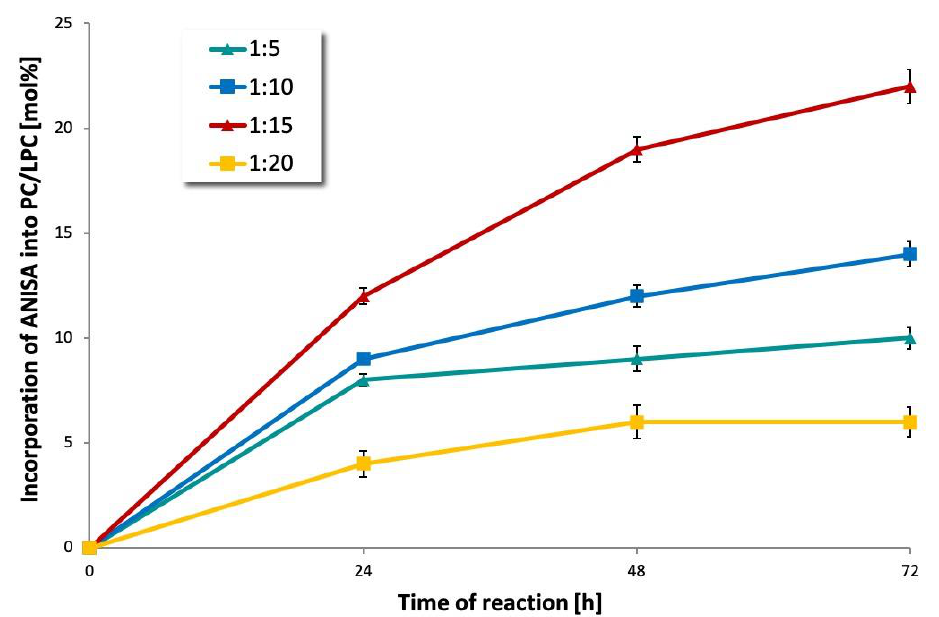
Figure 3. Effect of different substrate molar ratio on the incorporation of ANISA into egg-yolk PC in the acidolysis reaction (reaction conditions: solvent: toluene:chloroform (9:1 v/v) 2mL, enzyme load 30% (w/w) Novozyme 435, temperature 50 °C). Vertical bars represent SD, n = 3.